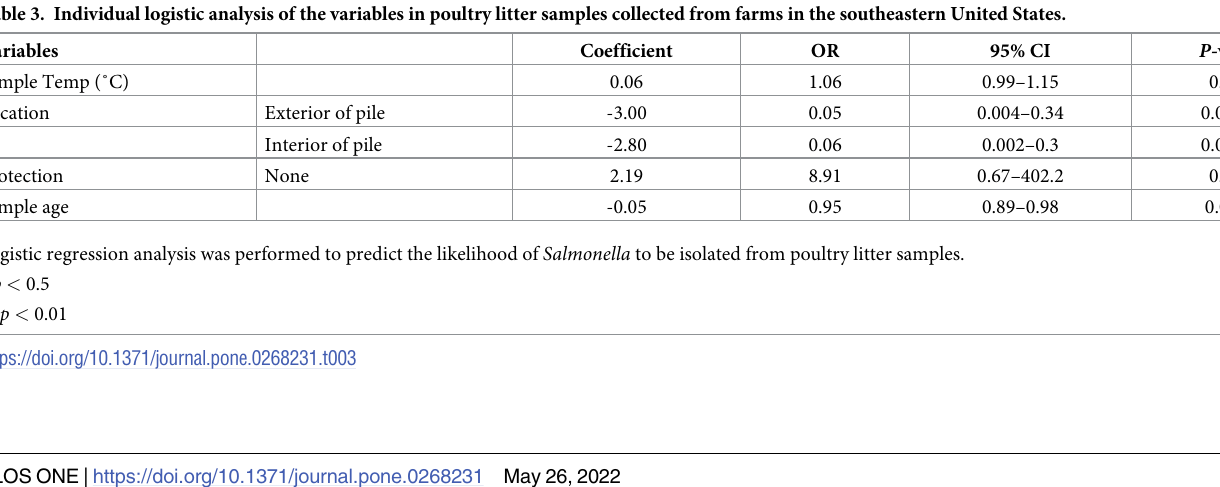
Table 3. Individual logistic analysis of the variables in poultry litter samples collected from farms in the southeastern United States. Variables